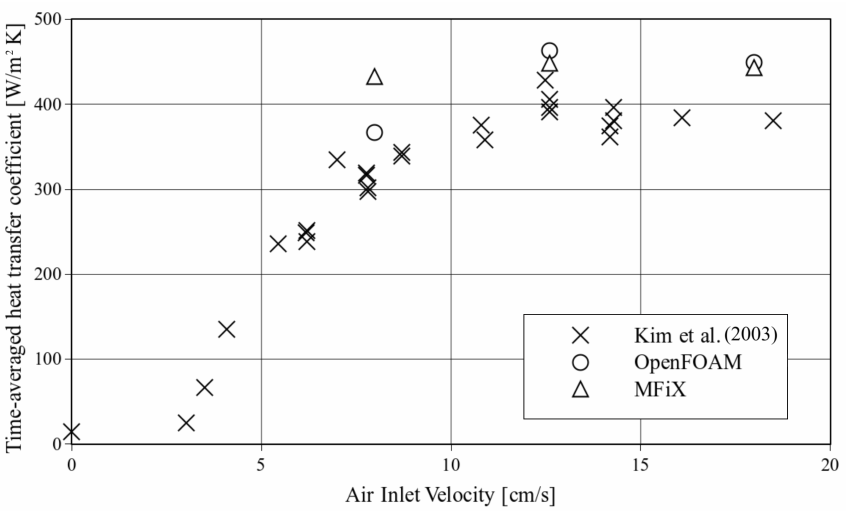
Figure 10. Time-averaged heat transfer coefficient around the tube predicted by simulation and experiments